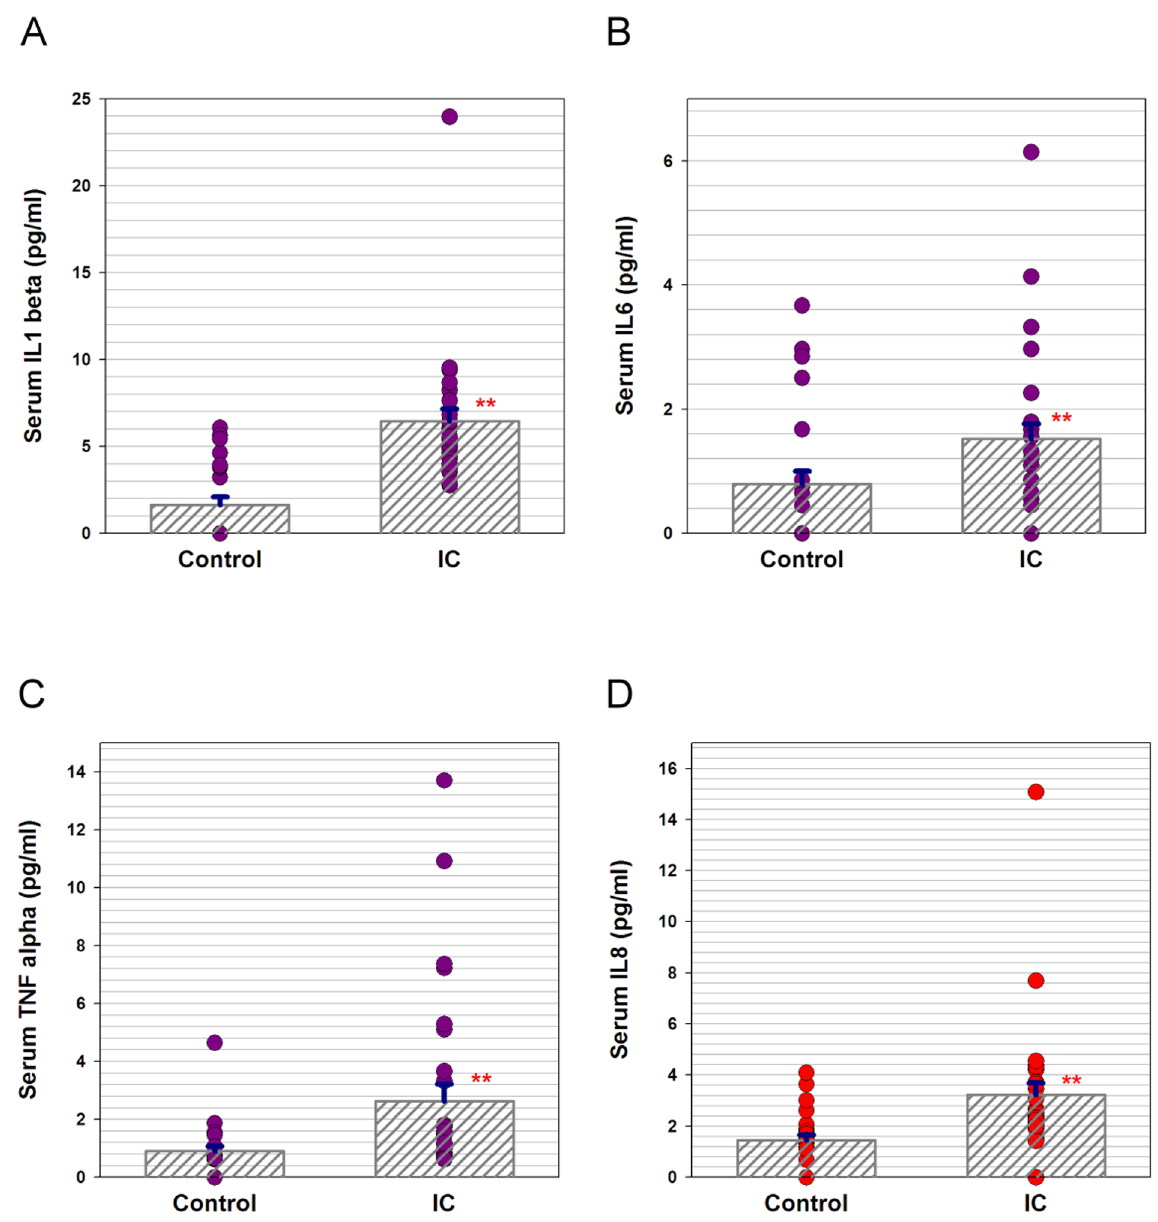
Figure 1. Scatter plots of serum (A) IL-1 b , (B) IL-6, (C) TNF- a , and (D) IL-8 levels in IC/BPS patients and control subjects.